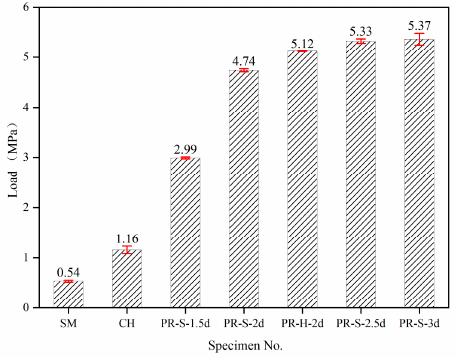
Figure 10. Comparison of shear strength of UHPC–NC interfaces.